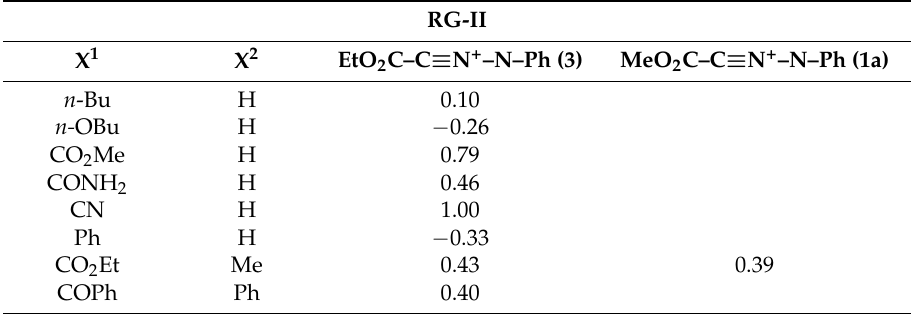
Table 8. Electron chemical potential difference µ (nitrilimine)– µ (ethene) in eV for the RG-II. Positive values indicate that the nitrilimine transfers electrons to the ethene.